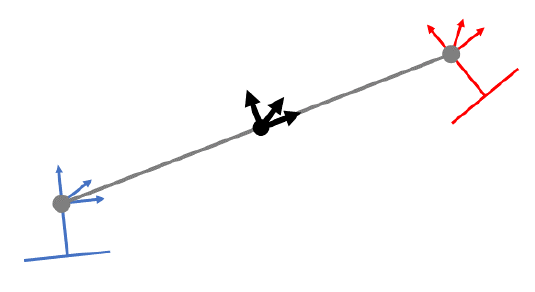
Figure 3: Dual camera system